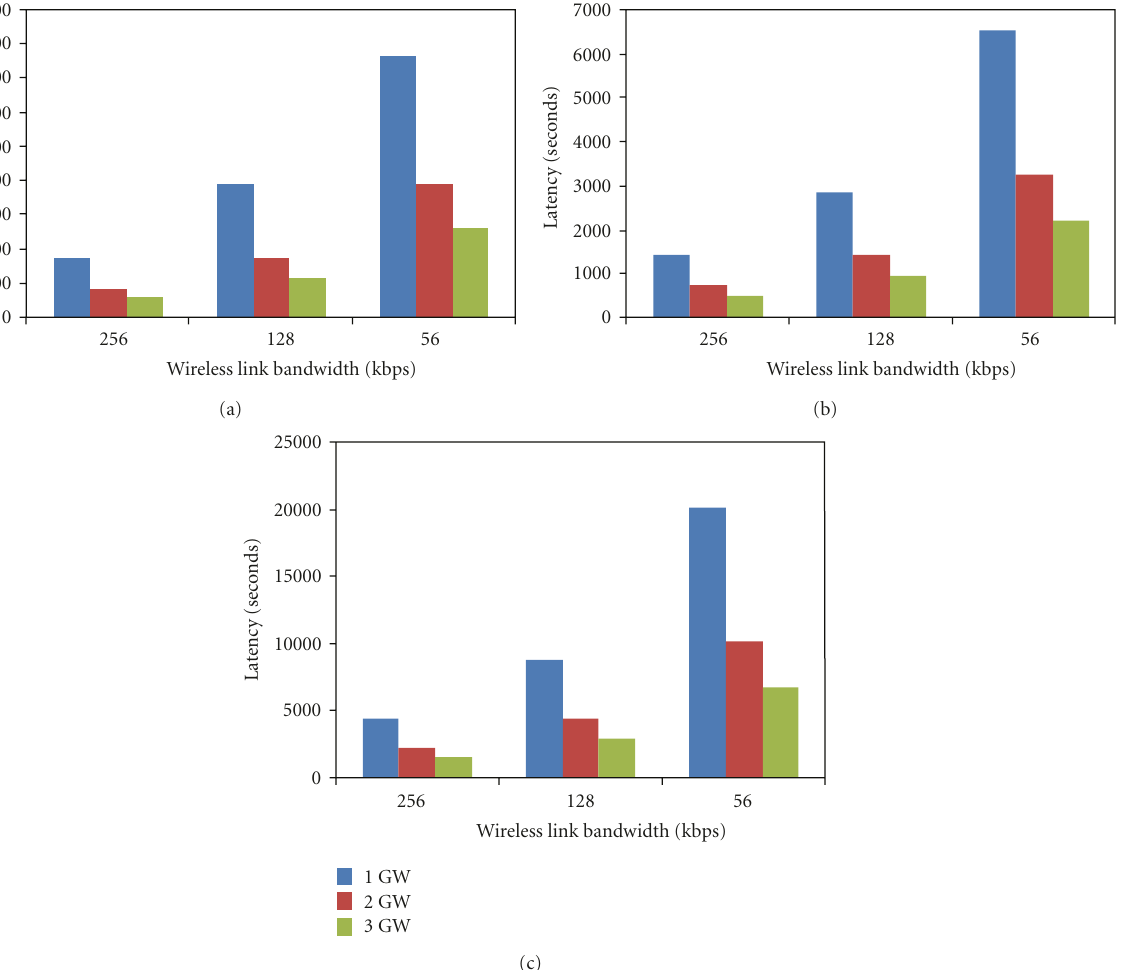
Figure 13: E ff ect of link bandwidths on latency of file transfer for file sizes (a) 5Kbytes, (b) 42Kbytes, and (c) 129Kbytes.